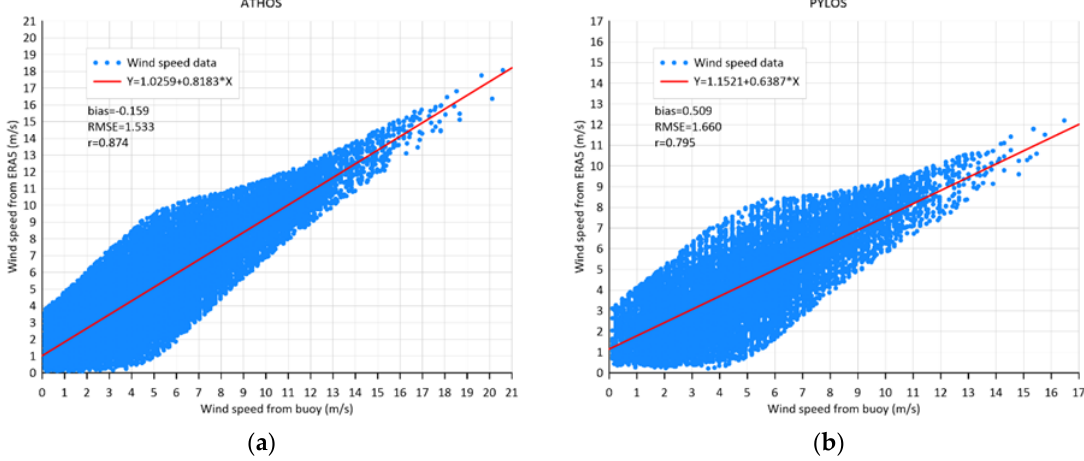
Figure 4. Scatter plots of 𝑢 𝑊 obtained from buoy and ERA5 dataset for Athos ( a ) and Pylos ( b ). The corresponding statistical results for 𝐻 𝑆 , 𝑇 𝑒 and 𝑢 𝑊 are summarized in Tables 2 – 4, respectively. Table 2. Results of data evaluation of the significant wave height 𝐻 𝑆 obtained from ERA5 and in- situ measurements.